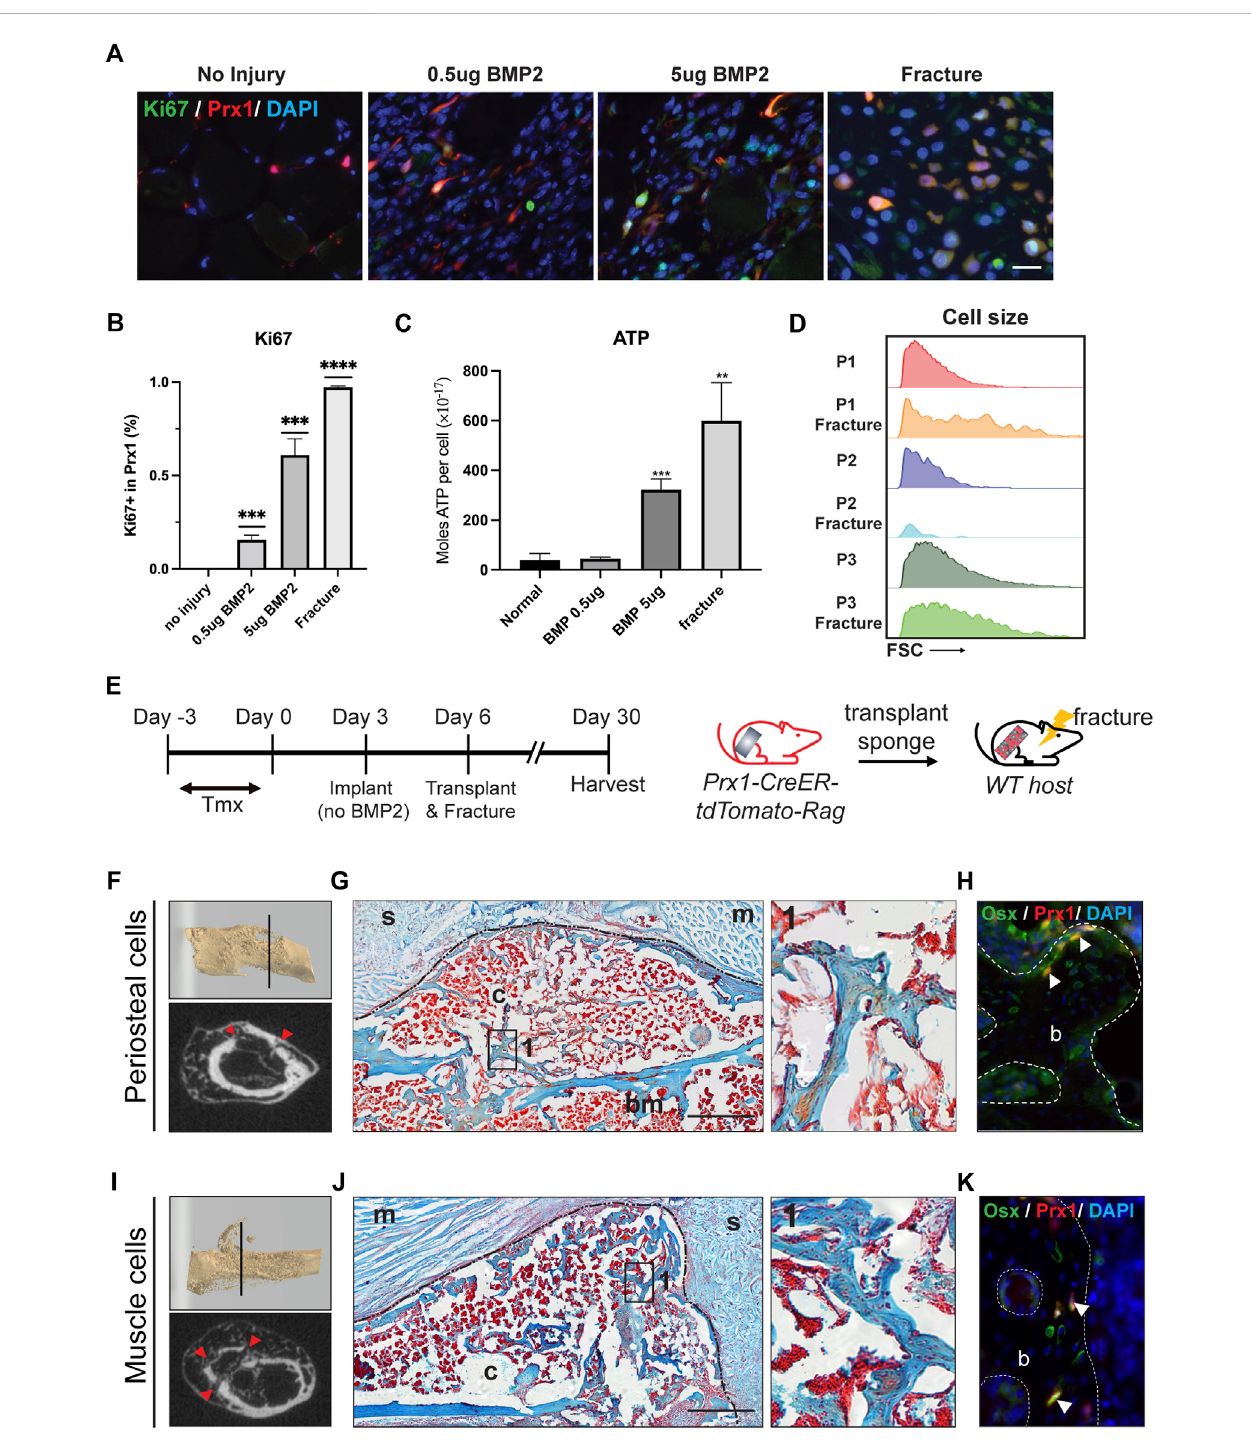
FIGURE 6 BMP2 and fracture activate muscle-derived Prx1 cells. (A) Co-labeling of Prx1 derived cells (red) with Ki67(green) in normal, BMP2 0.5µg, BMP2 5 µg and fracture conditions. Nuclei were labeled with DAPI (Blue). Scale bar = 25 μ m (B) . Quanti fi cation of Prx1-derived cells that are Ki67+ in normal, BMP2 0.5µg, BMP2 5 µg and fracture conditions. (C) . P1 isolated from fracture injured and BMP2 5 µg treated muscle display elevated ATP level than normal and BMP2 0.5 µg groups. One-way ANOVA was performed followed by Tukey test to assess statistical signi fi cance. ** p < 0.01, *** p < 0.001, **** p < 0.0001. n = 3. Data represent mean ± SD. (D). Compared with two other subsets, P1 subpopulations displayed a signi fi cant increase in cell size following fracture, as measuredbytheFSCparameterbyFACS. (E) .Schematicrepresentationofspongetransplantationwithfemurfracture. (F – H) .Resultsofperiosteumcellsfrom Prx1 reporter mice transplanted to the fracture femur of wild-type hosts. (I – K) . Results of muscle cells from Prx1 reporter mice transplanted to the fracture femurofwild-type hosts. (F,I) .Representativemicro-CToffracturecallusesandsurroundingtissue atDay24post-transplantation.Top:3Dreconstructionof fractured femur. Bottom: micro-CT slice images, red arrowhead indicates fracture sites. (G, J) . Longitudinal section of the sponge and femur, stained with SafraninO.Blackdottedlinesrepresentboundariesoffracturecallus.Right:Enlargedviewofboxedregion1showingboneformation. (H,K) .Adjacentsection immunostained with osterix (green). Nuclei were labeled with DAPI (blue). The white arrowheads indicate co-labeling of Prx1 derived cells (red) with osterix. Scale bar = 500 μ m for Safranin O, 50 µm for IF staining. B = bone; bm = bone marrow; c = callus; s = sponge; m = muscle. n =